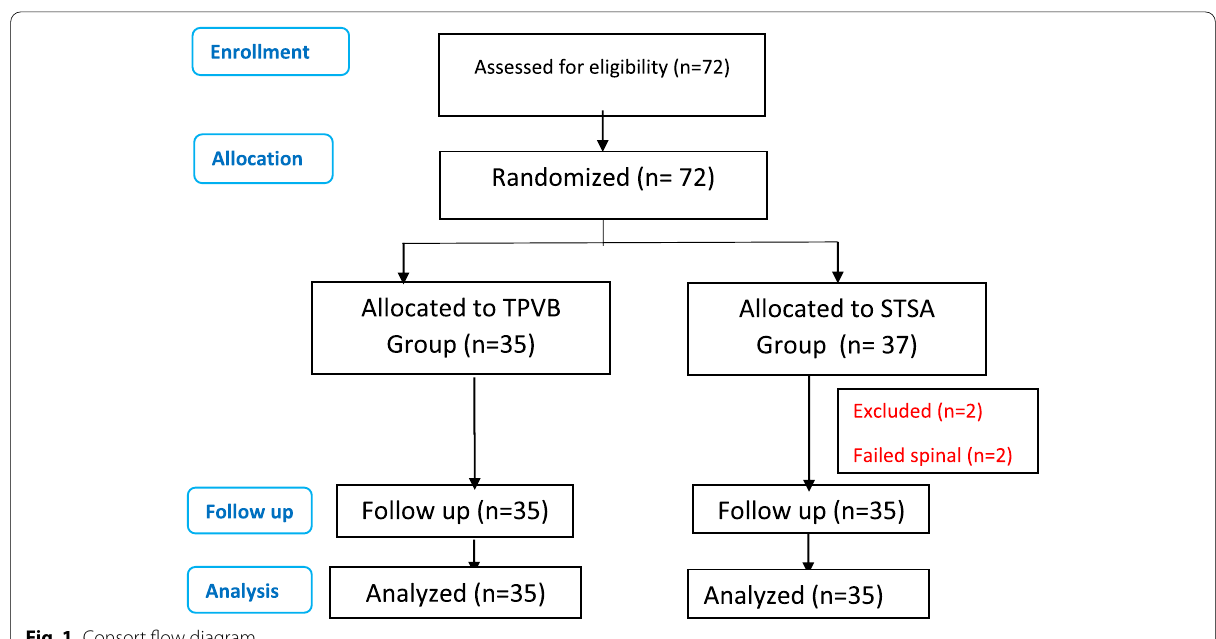
Fig. 1 Consort flow diagram